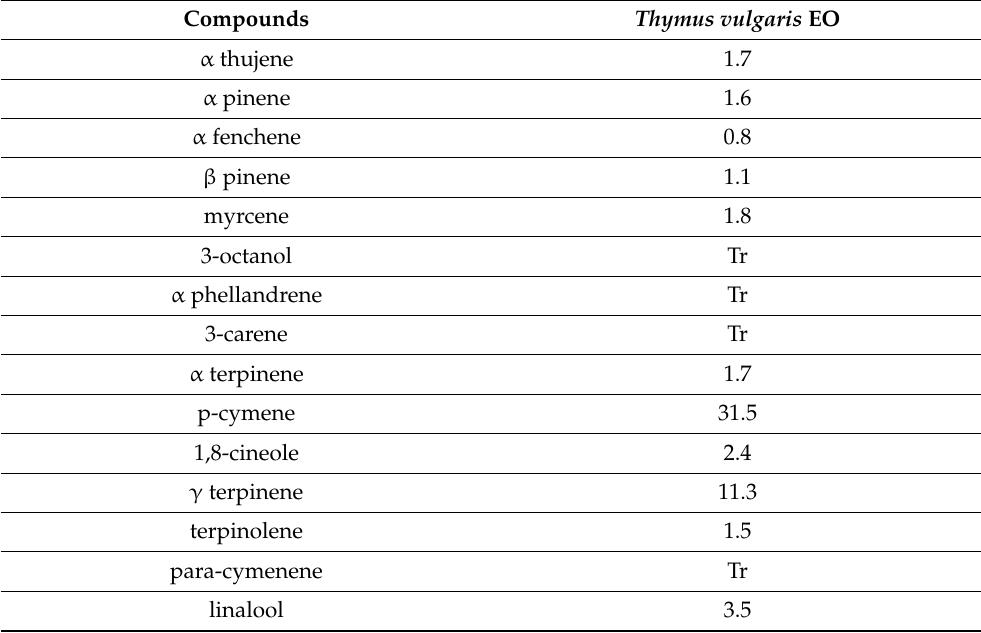
Table 2. Components identified in the essential oil of Thymus vulgaris (%) by GC-MS (Table extracted from Oliva et al. 2014